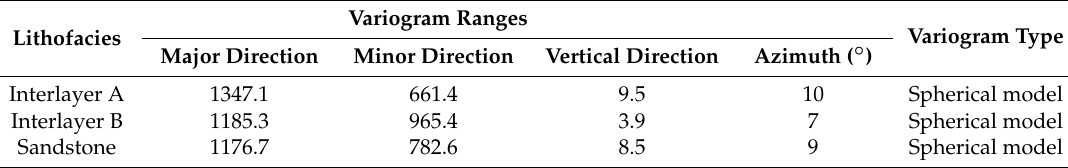
Table 2. Data used to model distribution of sandstone and mudstone for layer H8S1 in zone B.